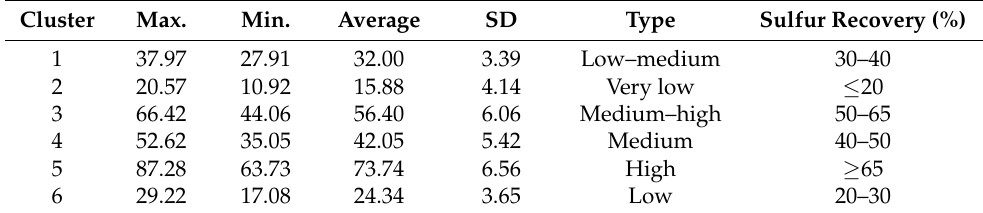
Table 6. Statistical results of predicted values in each cluster.